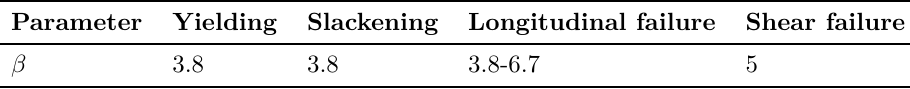
Table 2. The β -values per failure